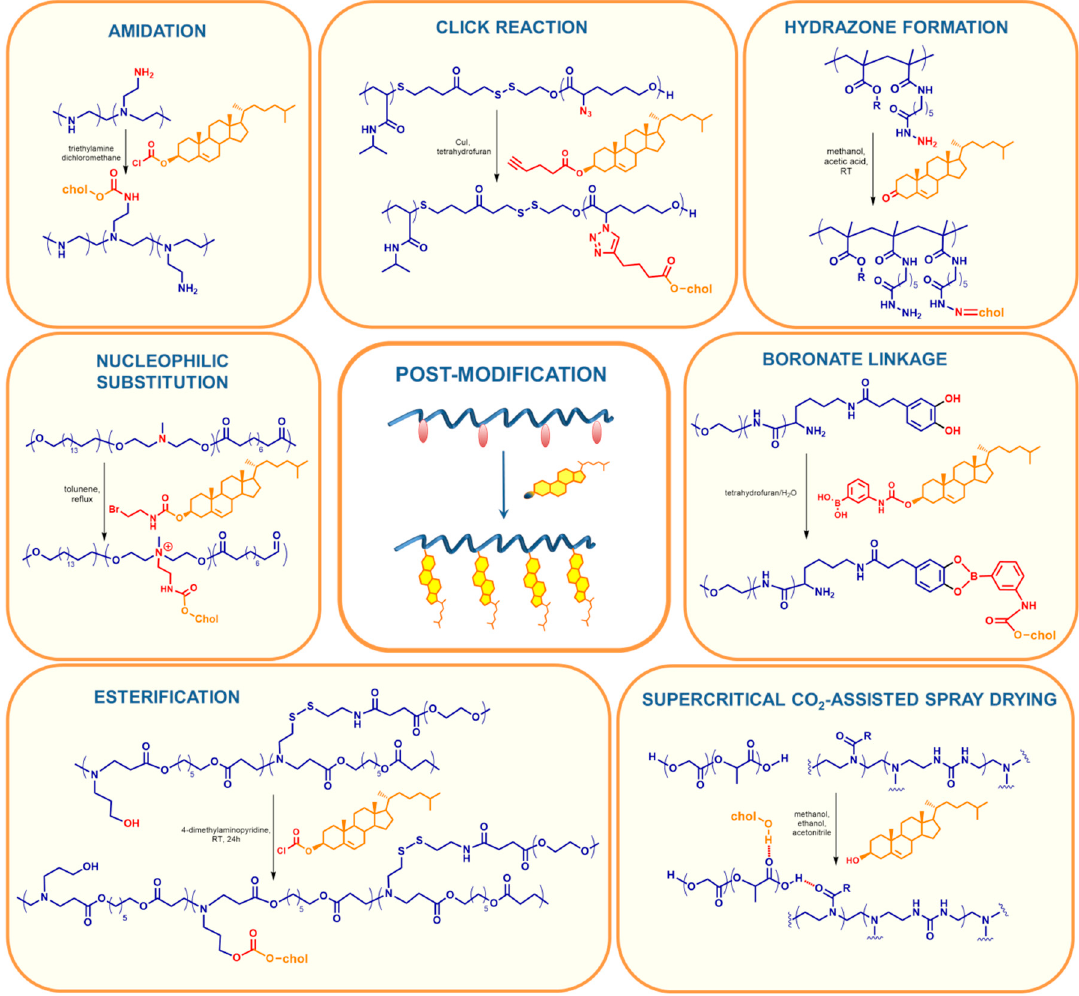
Figure 6. Methods of incorporation of cholesteryl moieties to side chains by post-polymerization reactions [20,38,39,80,130,132,133].